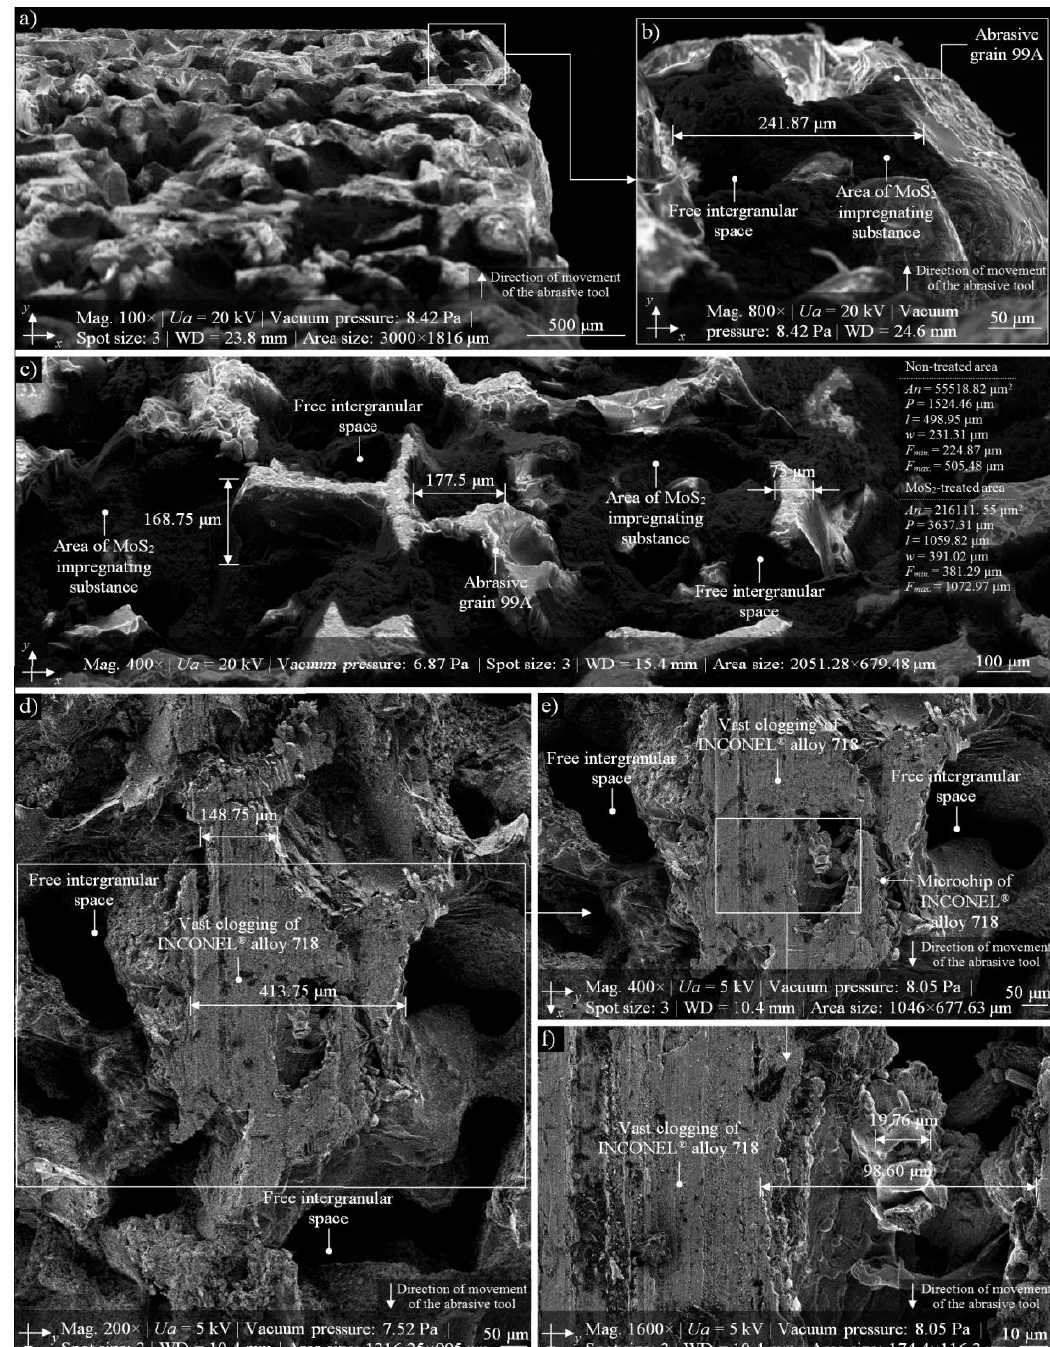
Figure 8. Collection of selected results obtained for the GWAS 1-35×10×10-9A5X60L10VE01PI-50 using the (environmental) scanning electron microscope FEI Quanta™ 250 for MoS 2 -treated samples: ( a ) SEM micrograph (area size: 3000 × 1816 μm, magnification: 100×) of GWAS fragment located on the right side of the grinding wheel (sample 1M40); ( b ) SEM micrograph (area size: 2051.28 × 679.48 μm, magnification: 400×) extracted from Figure 8a with clearly visible MoS 2 impregnating substance; ( c ) SEM micrograph (area size: 2051.28 × 679.48 μm, magnification: 400×) of a vast panorama of another fragment of sample 1M40; ( d ) SEM micrograph (area size: 1316.25 × 995 μm, magnification: 200×) of the GWAS of sample 2M30 with a vast area of clogging of the machined material located in its center; ( e ) SEM micrograph (area size: 1046 × 677.63 μm, magnification: 400×) extracted from ( d ); ( f ) SEM micrograph (area size: 174.40 × 116.30 μm, magnification: 1600×) extracted from ( e ).